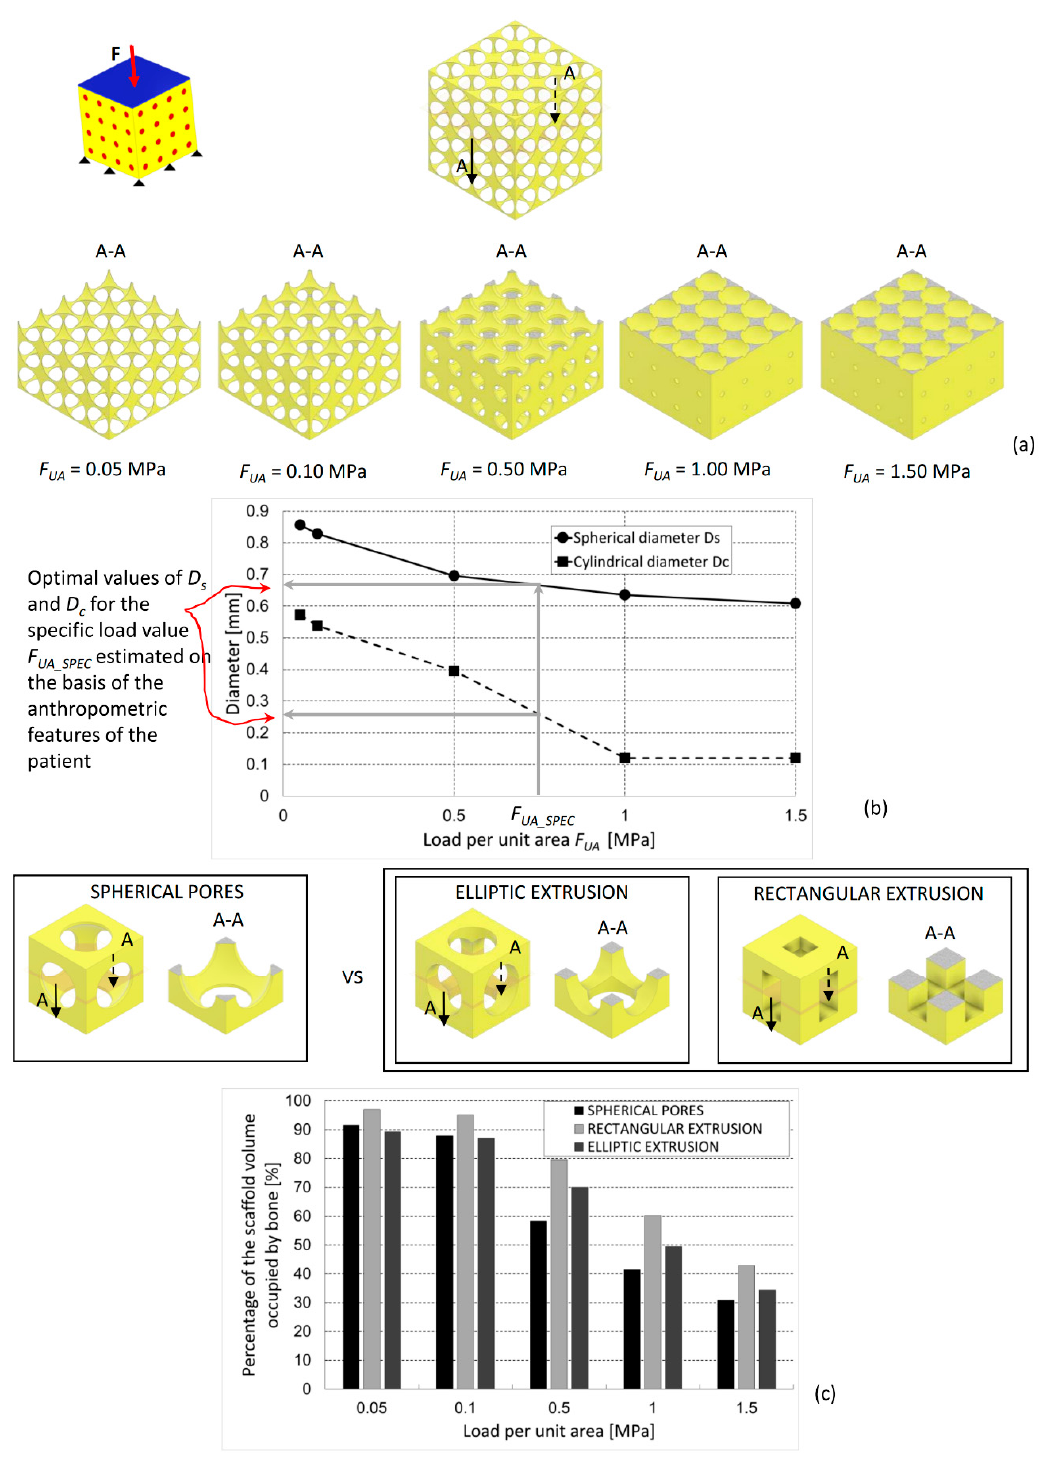
( c ) percentage of the scaffold volume occupied by mature bone, predicted by the optimization algorithm for different values of the compression load. The percentages of bone are compared with those predicted for scaffolds with hexahedron unit cells including elliptic and rectangular extrusions [20].